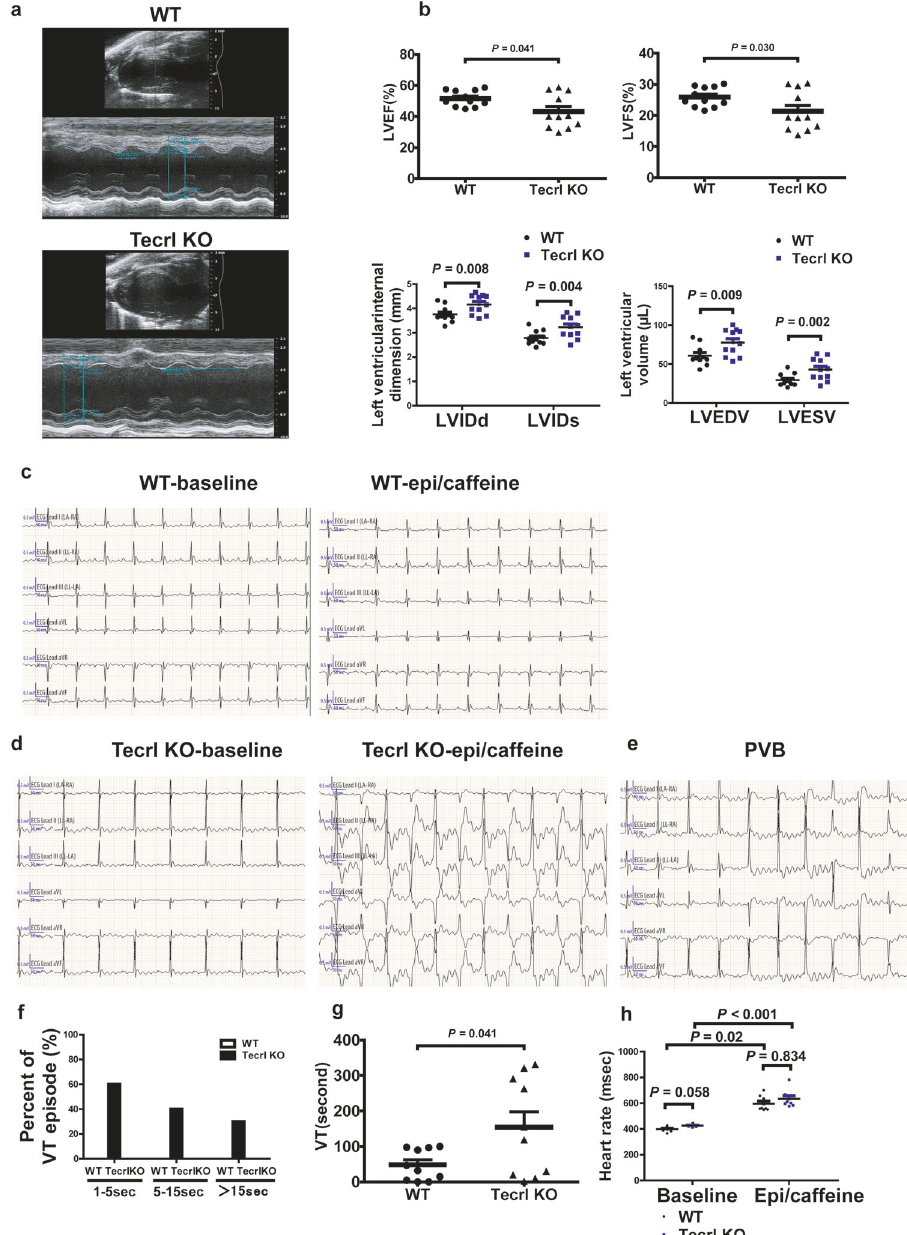
Fig. 2 Tecrl de fi ciency-induced cardiac dysfunction. a Representative echocardiography images of WT and Tecrl KO mice. b Quanti fi cation of LVEF, LVFS, LVIDd, LVIDs, LVEDV, and LVESV in WT and Tecrl KO mice (8 weeks) ( n = 8). c – f Representative ECG recordings and percent of VT episode (%) in WT and Tecrl KO mice before and after epi/caffeine stimulation ( n = 10). g Quanti fi cation of VT ( n = 10). h Quanti fi cation of mice heart rate ( n = 8). Values are mean ± SE. P < 0.05 was considered signi fi